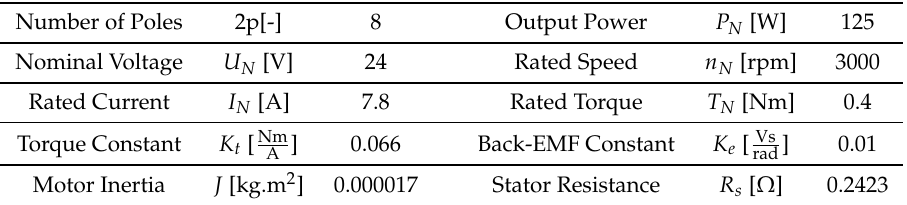
Table 1. Parameters of used three-phase PM motor ACT 57BLF02.